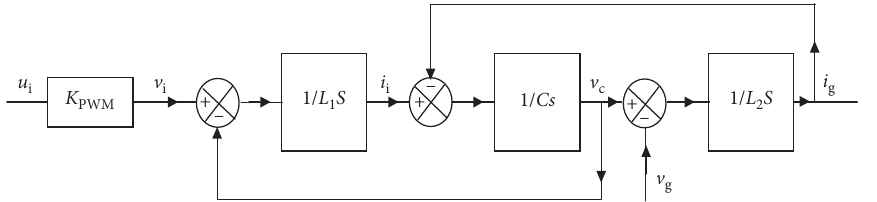
Figure 2: Block diagram of the inverter and LCL filter in S